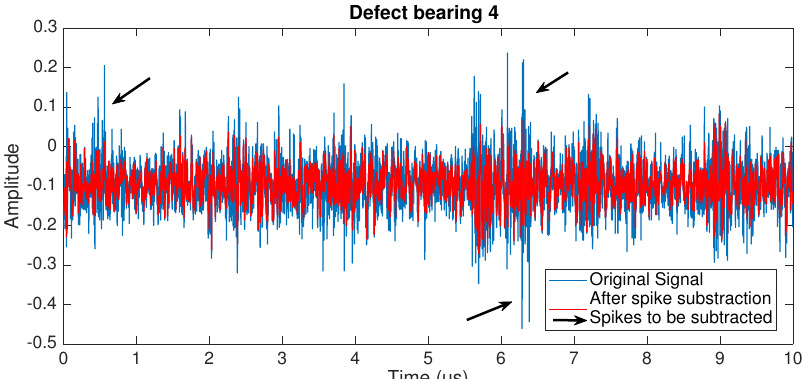
Figure 2. Demonstration of spike subtraction algorithm on open source IMS bearing data set.